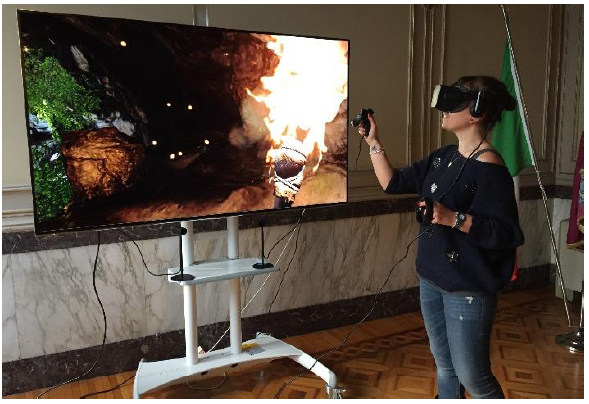
Figure 11. User experience testing